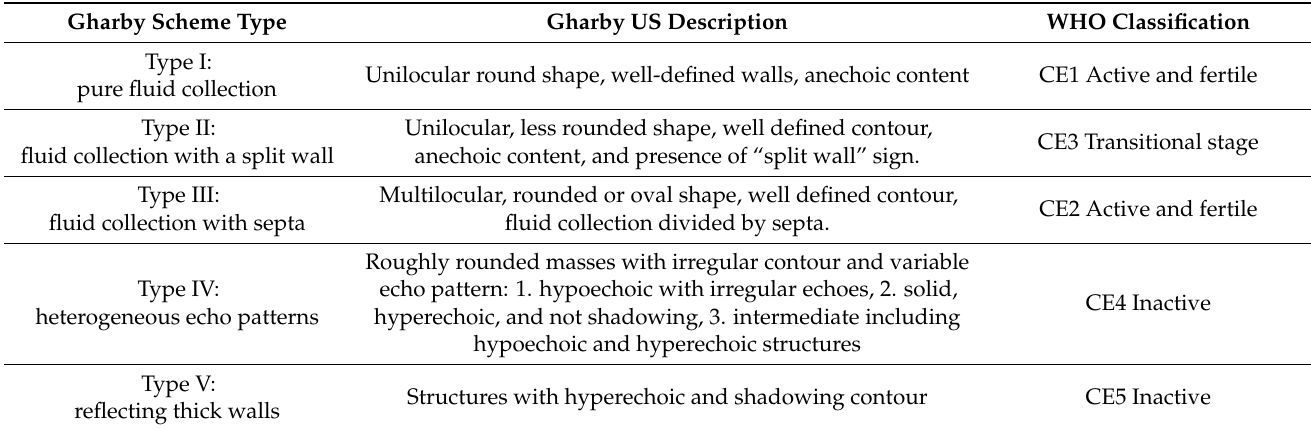
Table 1. Ultrasonographic World Health Organization classification of Echinococcus